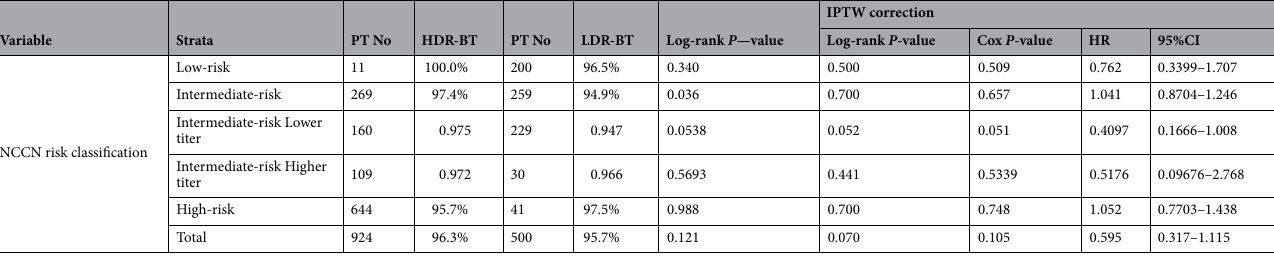
Table 3. The 5-year biochemical control rates corrected by Inverse probability of treatment weighting analysis.